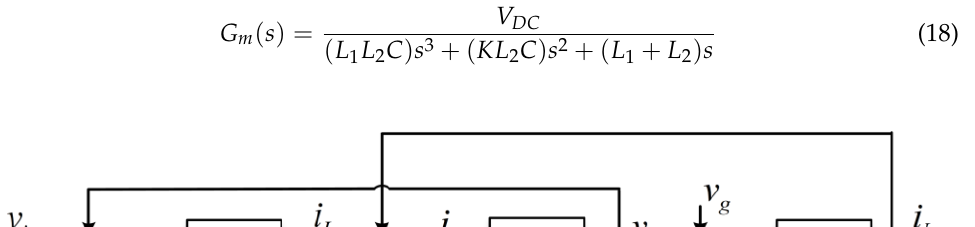
Figure 3. Frequency analysis of the designed LCL filter.